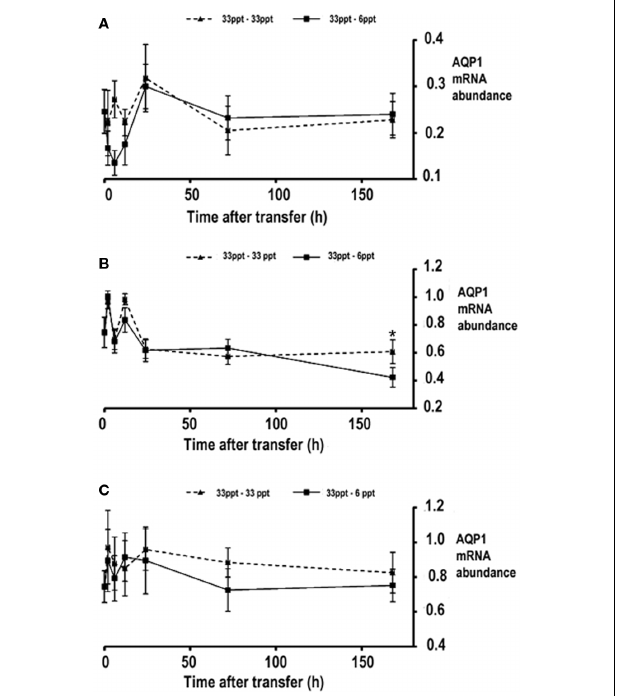
FIGURE 3 | Expression ofAQP1a transcript in gill (A), intestine (B), and kidney (C) of silver sea bream that were acclimated to freshwater (0ppt), hypoosmotic (6ppt), isoosmotic (12ppt), seawater (33ppt), hypersaline (50ppt), and extreme hypersaline (70ppt) for 1month. Data is presented as normalized AQP1a transcript abundance (arbitrary units) and values are expressed as mean ± SEM ( n = 7). Different letters above a bar denote significant differences among salinity acclimated groups ( p < 0.05).